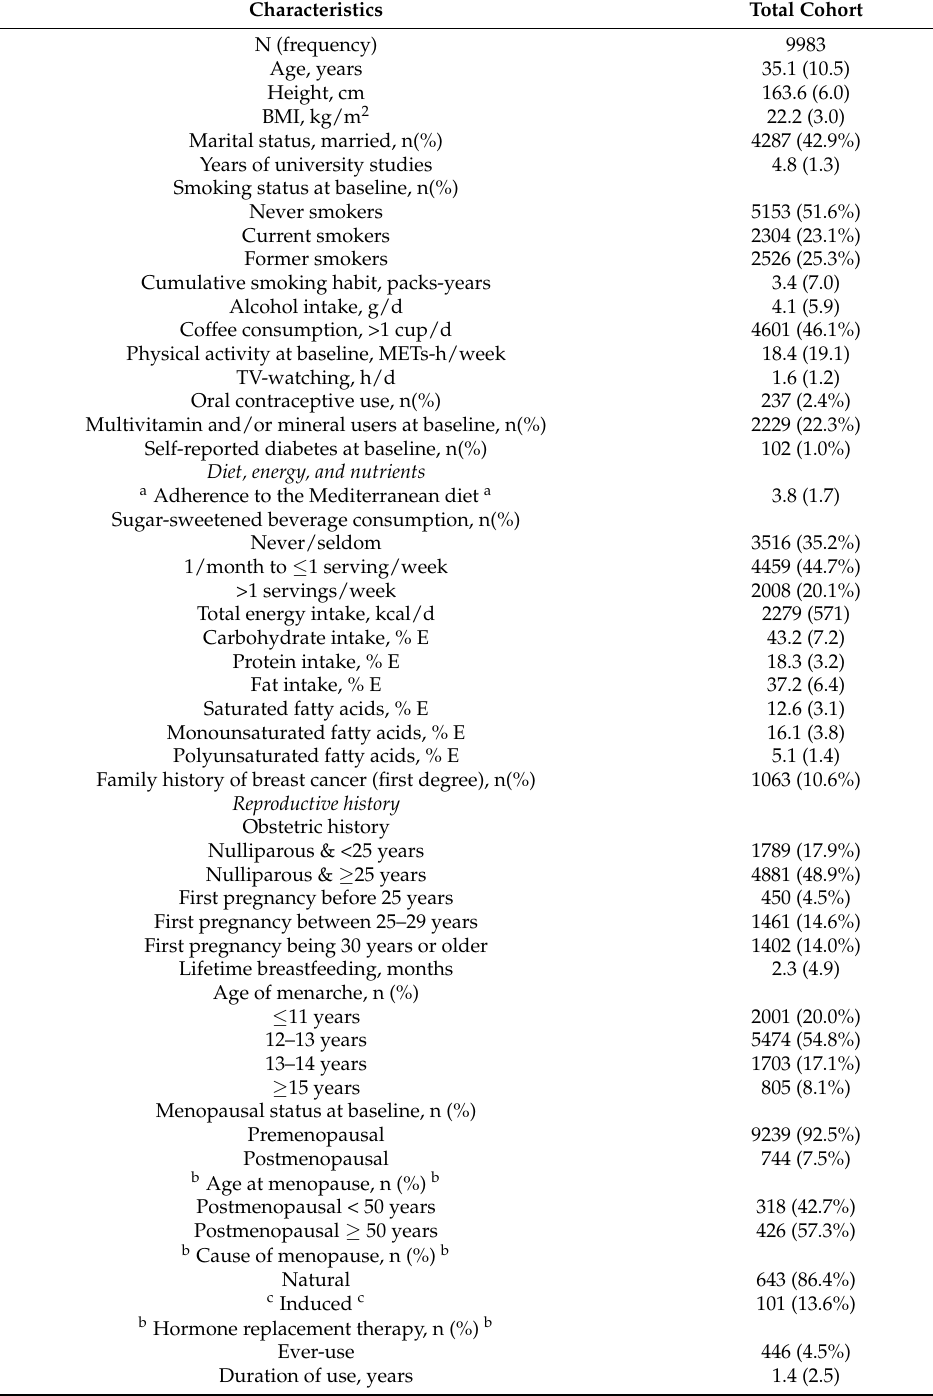
Table 1. Baseline characteristics of the female study participants of the Seguimiento Universidad de Navarra (SUN) Project ( n =